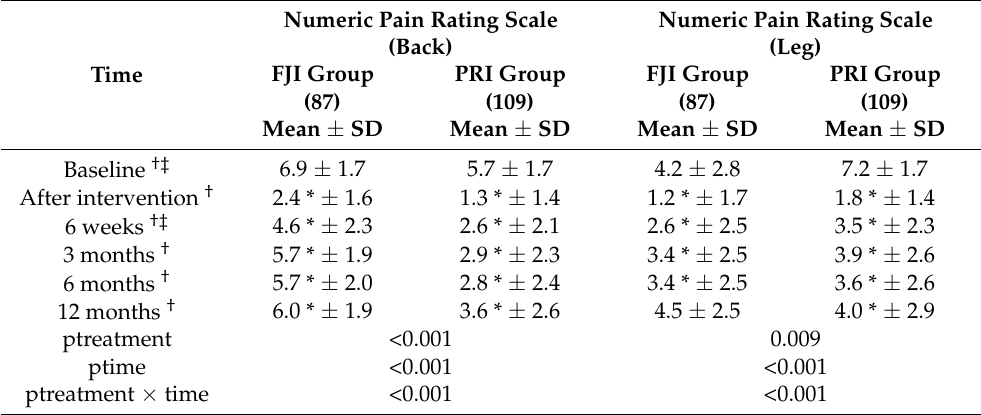
Table 3. Comparison of Numeric Pain Rating Scale for back pain and leg pain between the groups over